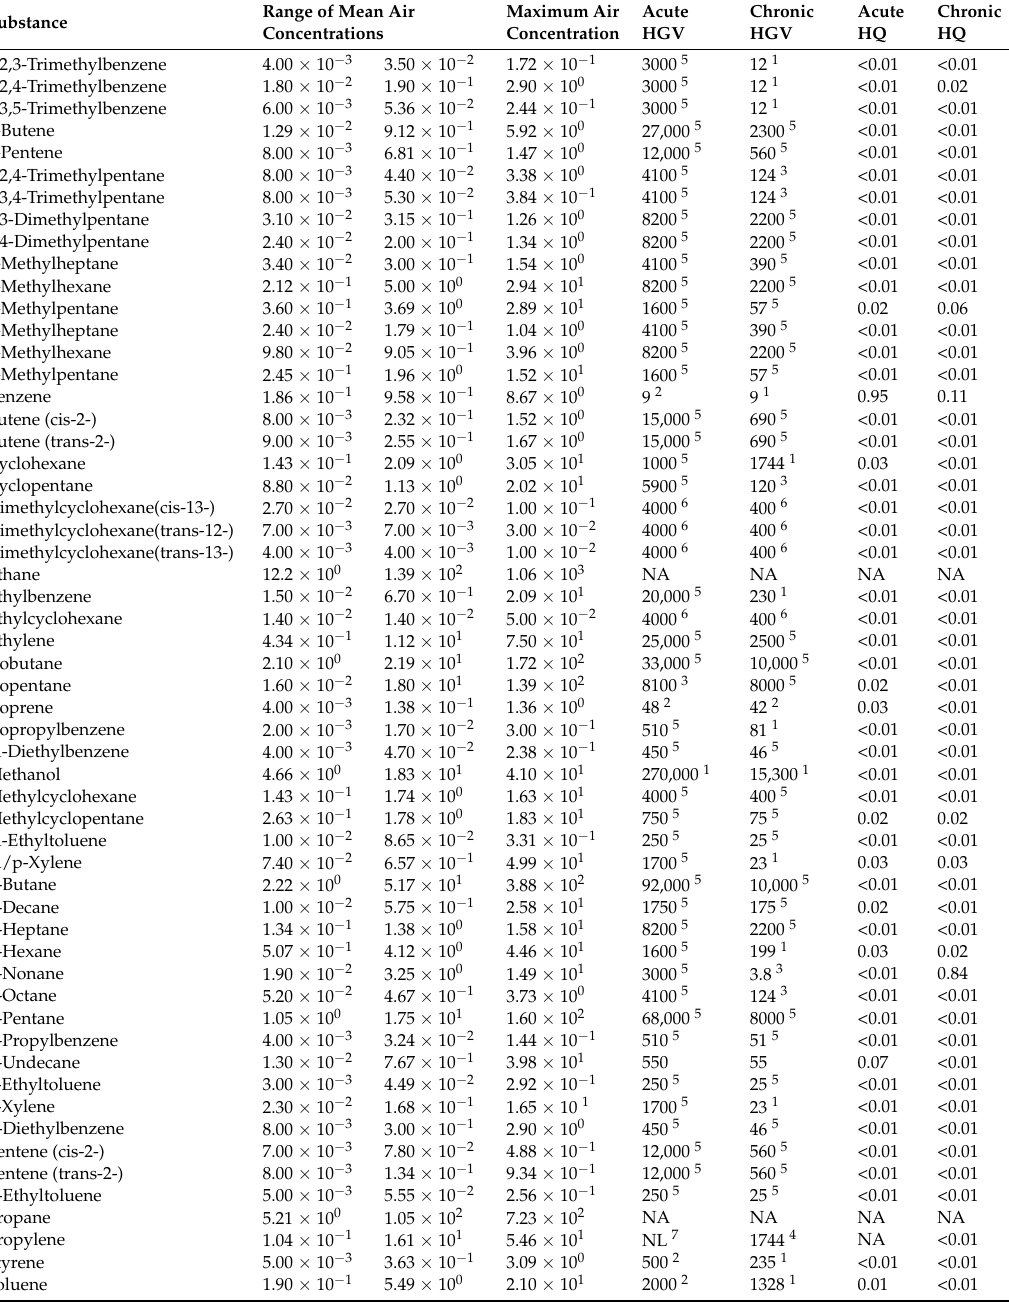
Table 3. Summary of combined air data, selected health guideline values (HGV) and calculated hazard quotients (HQs) for all non-cancer VOC’s. All concentration values in ppb; HQ are unitless.